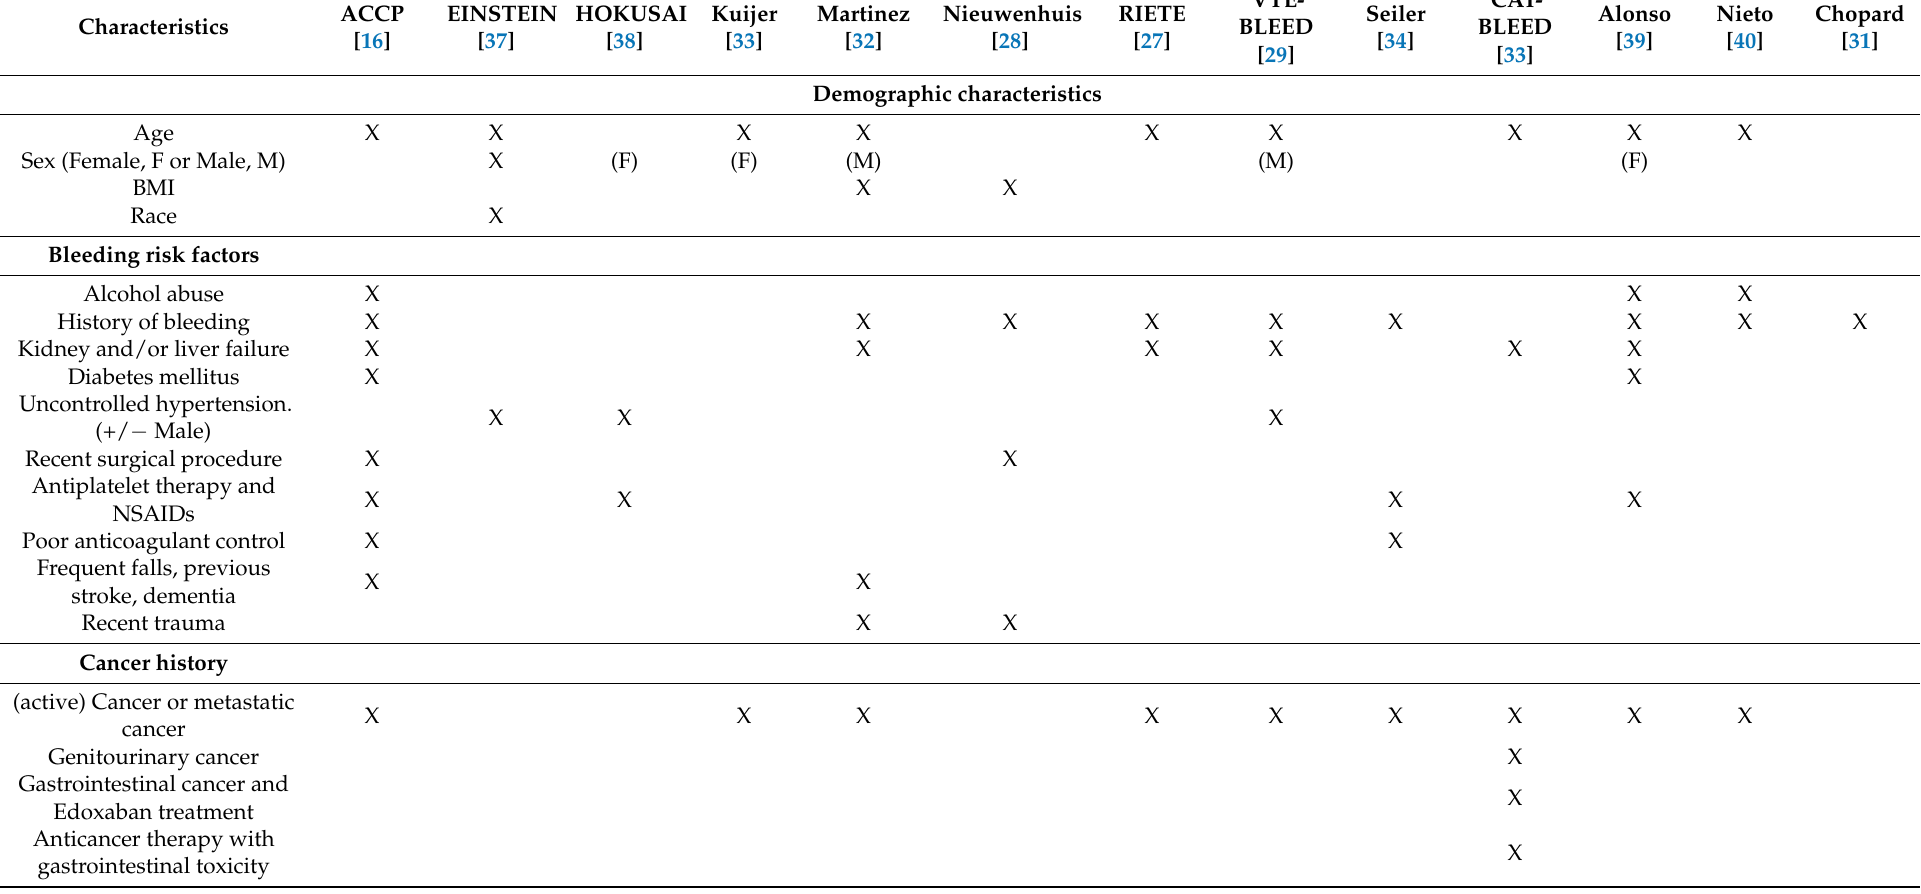
Table 3. Prediction factors for anticoagulant-associated bleeding